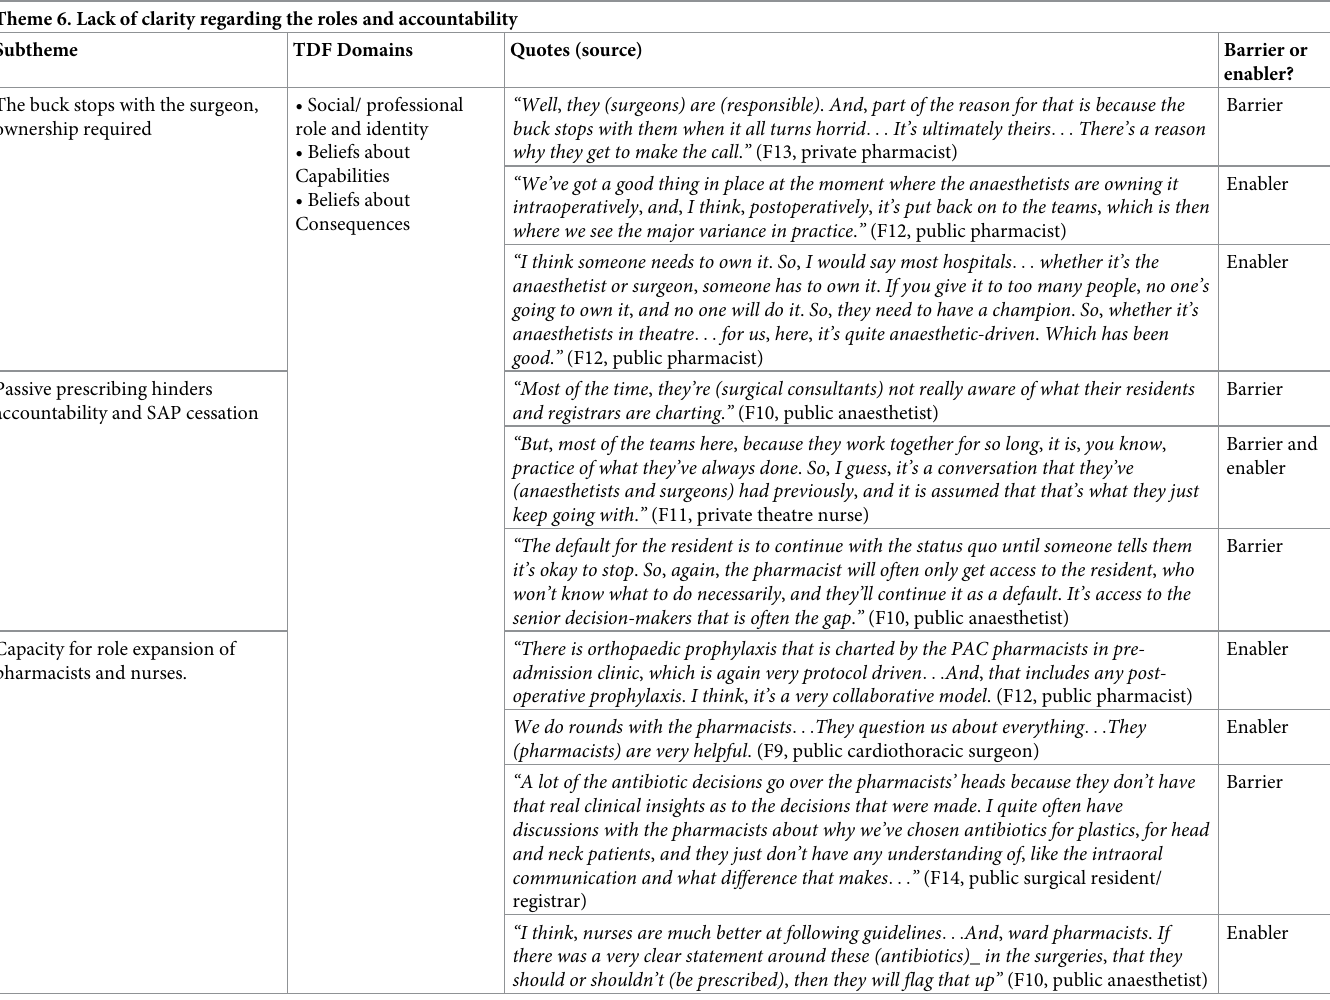
Table 8. Representative quotations from Theme 6 reflecting ‘Reflective Motivation’ of the COM-B model. Theme 6. Lack of clarity regarding the roles and accountability Subtheme The buck stops with the surgeon, ownership